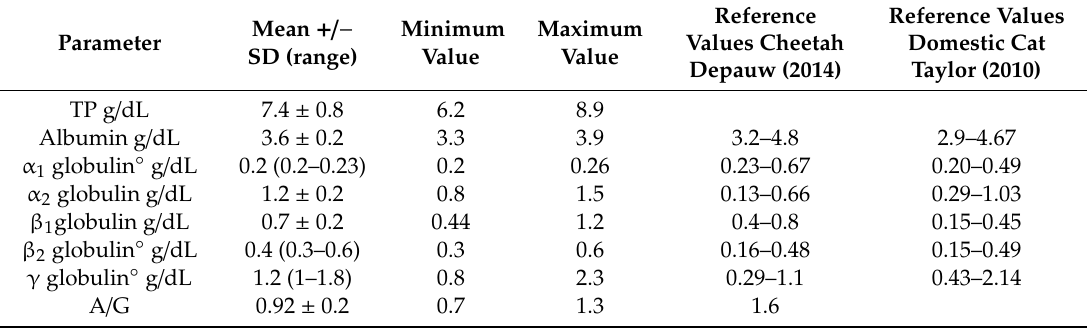
Table 1. Total protein concentration and concentrations of albumin and α 1, α 2, β 1, β 2 and γ globulin fractions, obtained using agarose gel electrophoresis (AGE), in 11 healthy captive tigers. Mean, SD, minimum and maximum value. Reference value of electrophoretic fractions in cheetah and domestic cats from previous studies. ◦ data non-normally distributed.